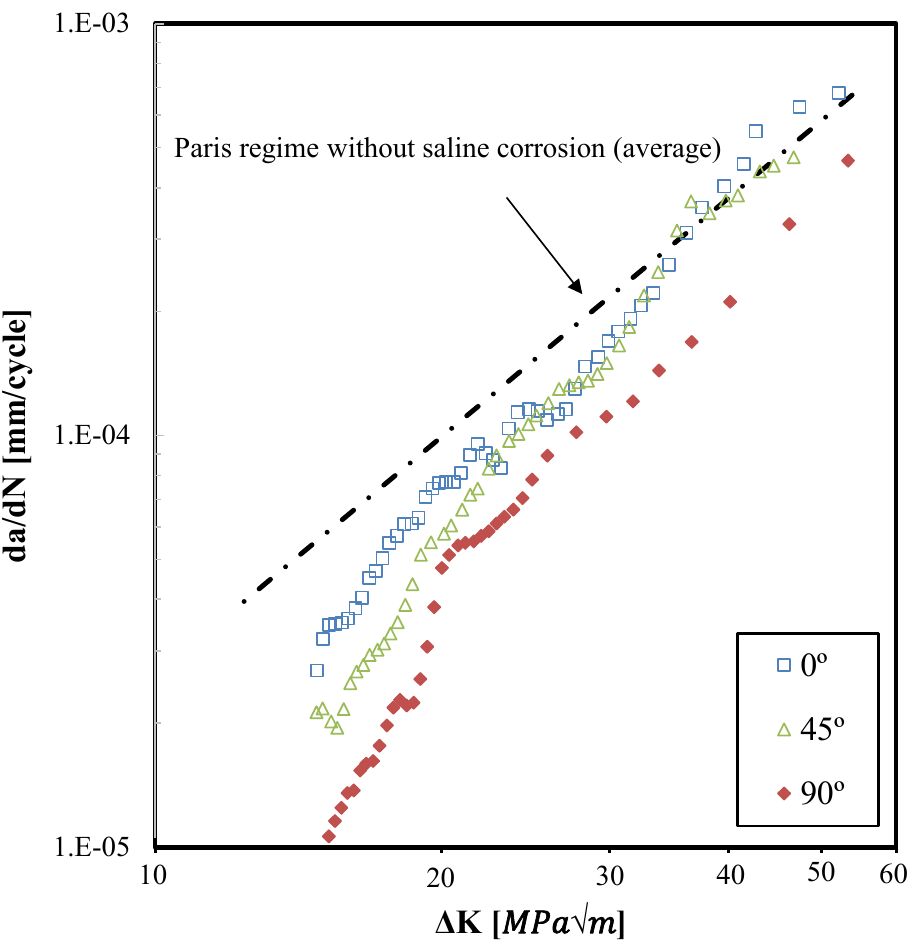
Figure 7. da/dN curves for β = 0°, β = 45° and β = 90° under saline corrosion.